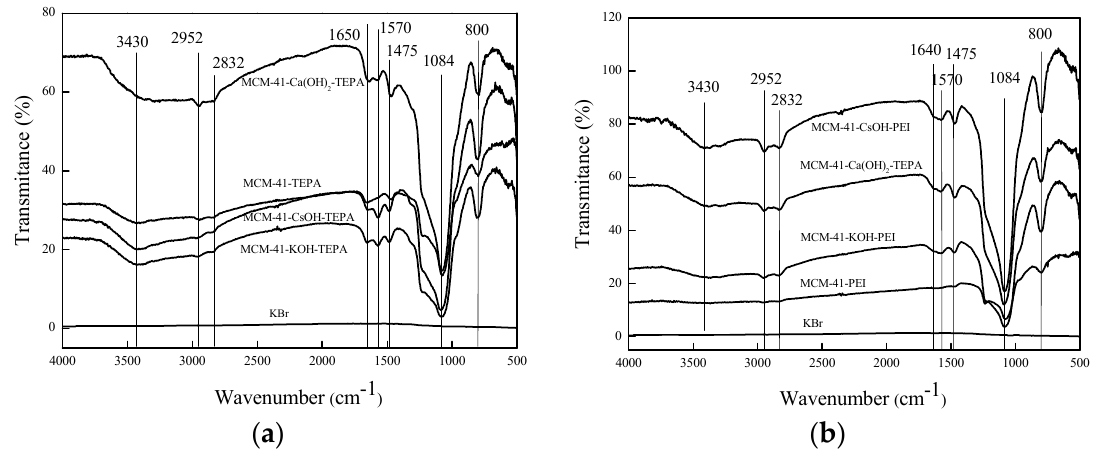
Figure 2. FT ‐ IR spectra of MCM ‐ 41 modified by ( a ) TEPA ( b ) PEI and various alkali components. Figure 2. FT-IR spectra of MCM-41 modified by ( a ) TEPA ( b ) PEI and various alkali components.